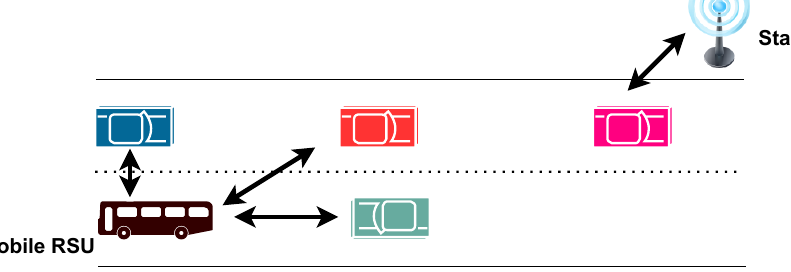
Figure 4. Public transportation as